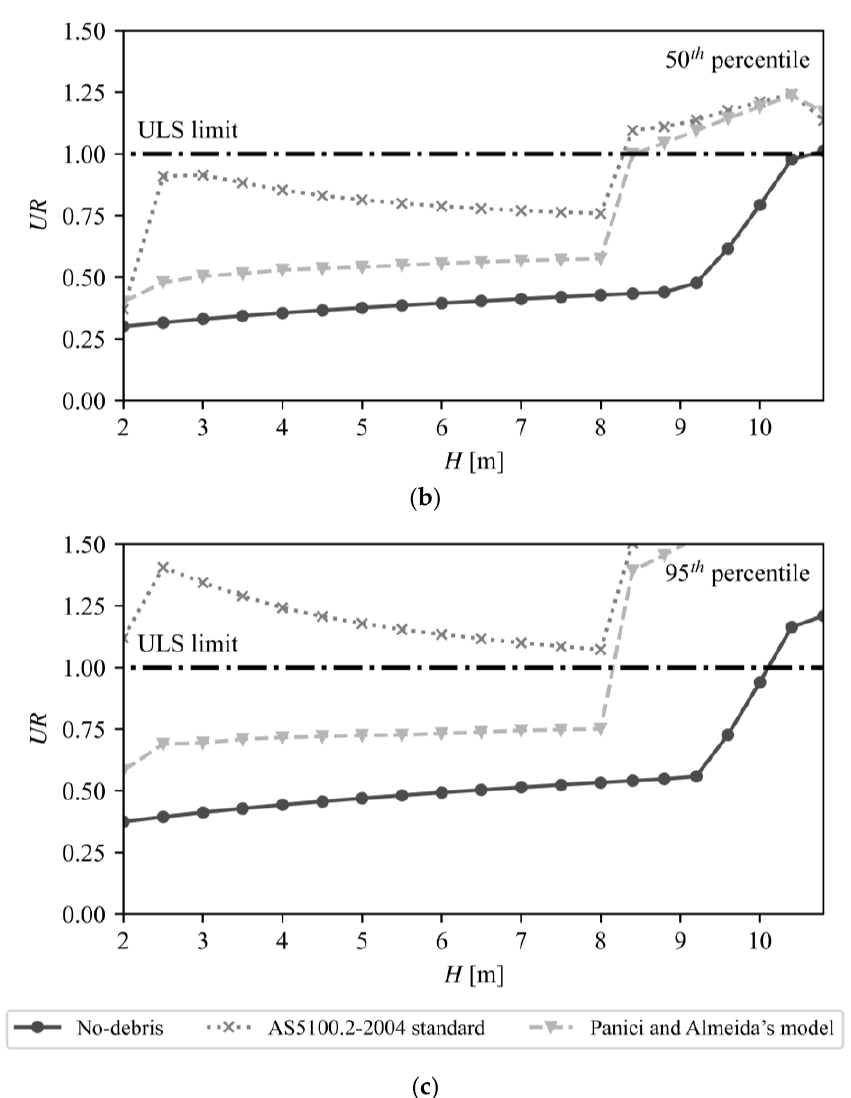
Figure 15. Representation of the ( a ) 5th, ( b ) 50th, and ( c ) 95th percentiles of the failure utilization ratios ( 𝑈𝑅 ) against the water heights ( 𝐻 ) for the three different scenarios and for the upper prediction bound of the 𝐻 − 𝑣 relationship.